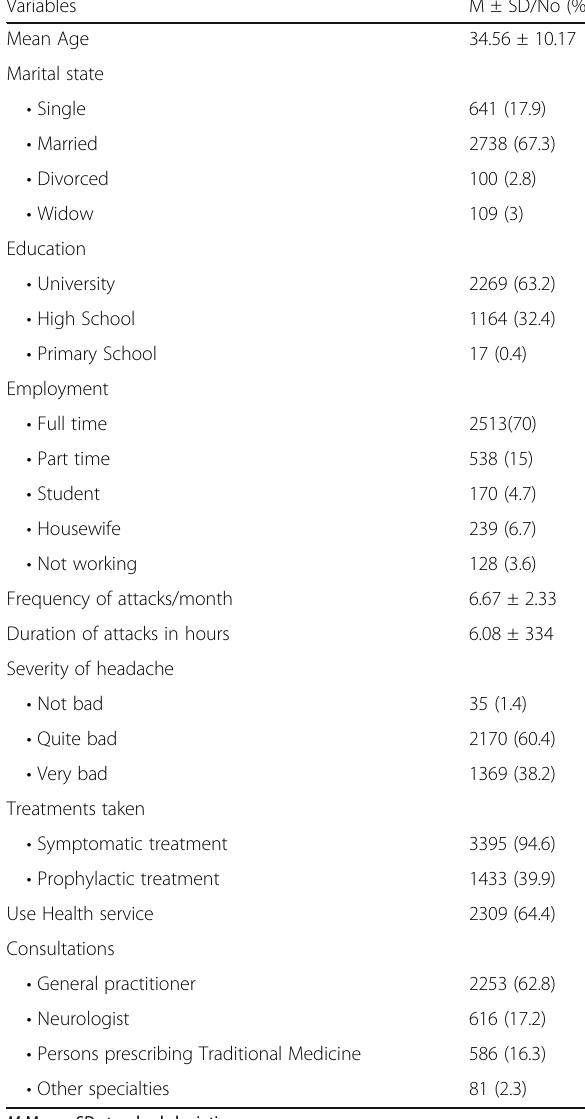
Table 2 Character of episodic migraine headache